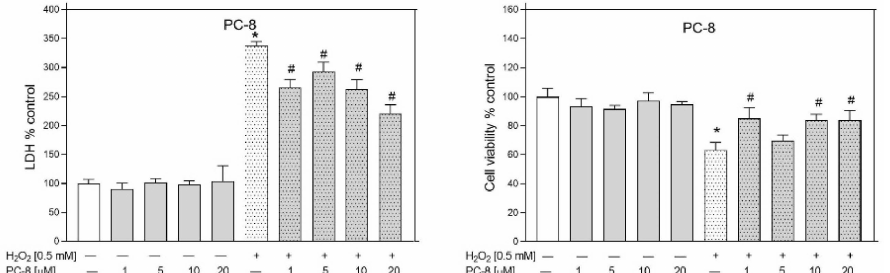
Figure 10. Effect of α , γ , δ -Tt, and PC-8 against H 2 O 2 -induced damage in RA-SH-SY5Y cells. The cells were pre-treated for 30 min with different ranges of Tts concentrations (0.5–20 µ M) and PC-8 (1–20 µ M). Then, 24 h after H 2 O 2 -induced damage (0.5 mM), the cell toxicity by LDH release assay ( left panel ) and cell viability by MTT reduction assay ( right panel ) were measured. Data after normalization to control cells (100%) are presented as the mean ± SEM from 2–4 independent experiments with five replicates. All group means were compared by a two-way ANOVA test followed by Duncan’s post hoc test. * p < 0.05 versus control culture and # p < 0.05 versus H 2 O 2 -treated cells.